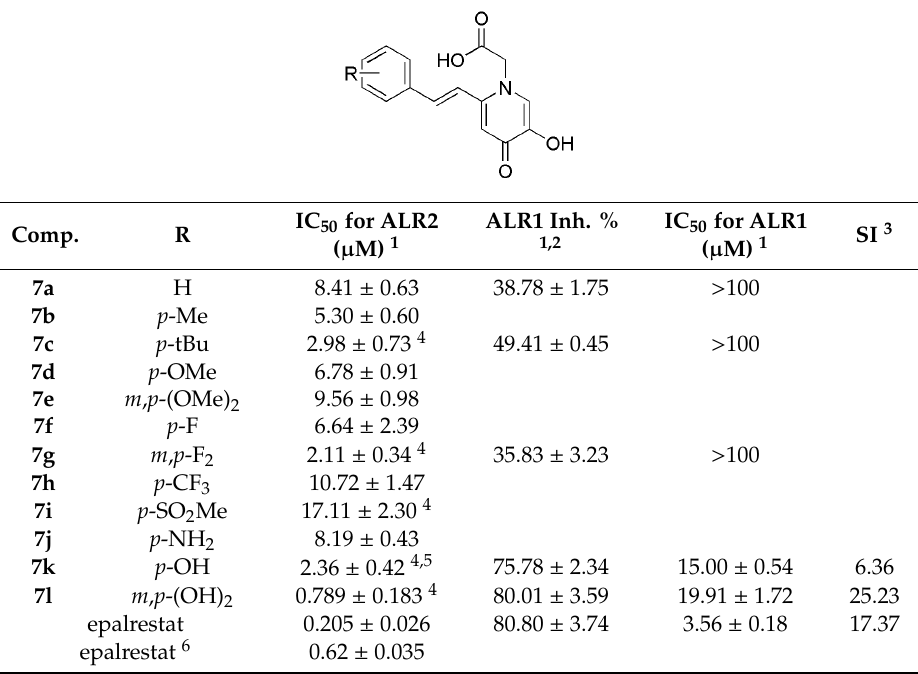
Table 1. Enzyme inhibition activity of 5-hydroxy-4-oxo-2-styryl-4H-pyridinone derivatives.